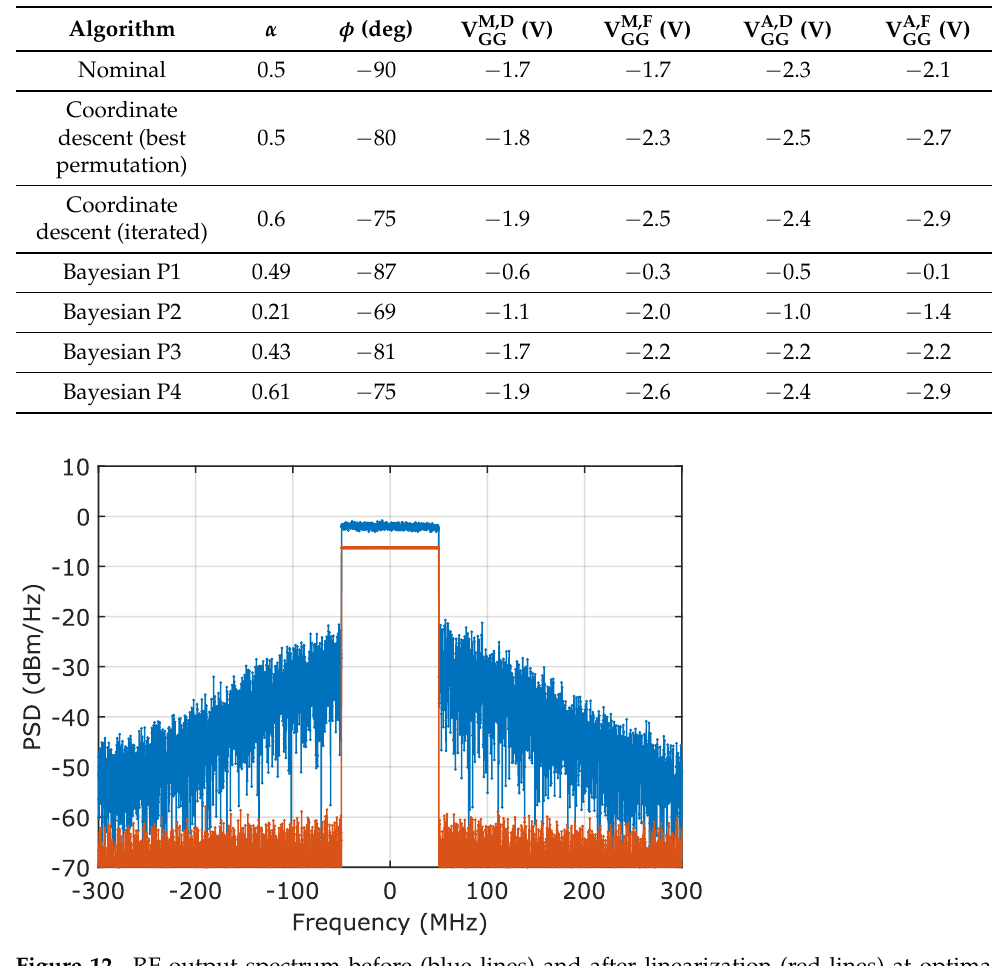
Figure 12. RF output spectrum before (blue lines) and after linearization (red lines) at optimal point P3.